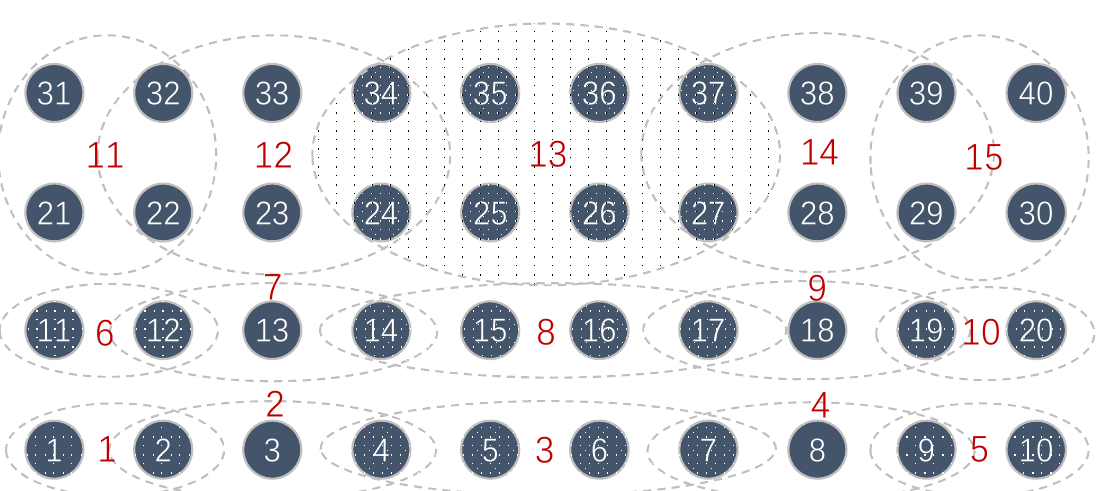
Figure 6. The schematic diagram of the force-pad.